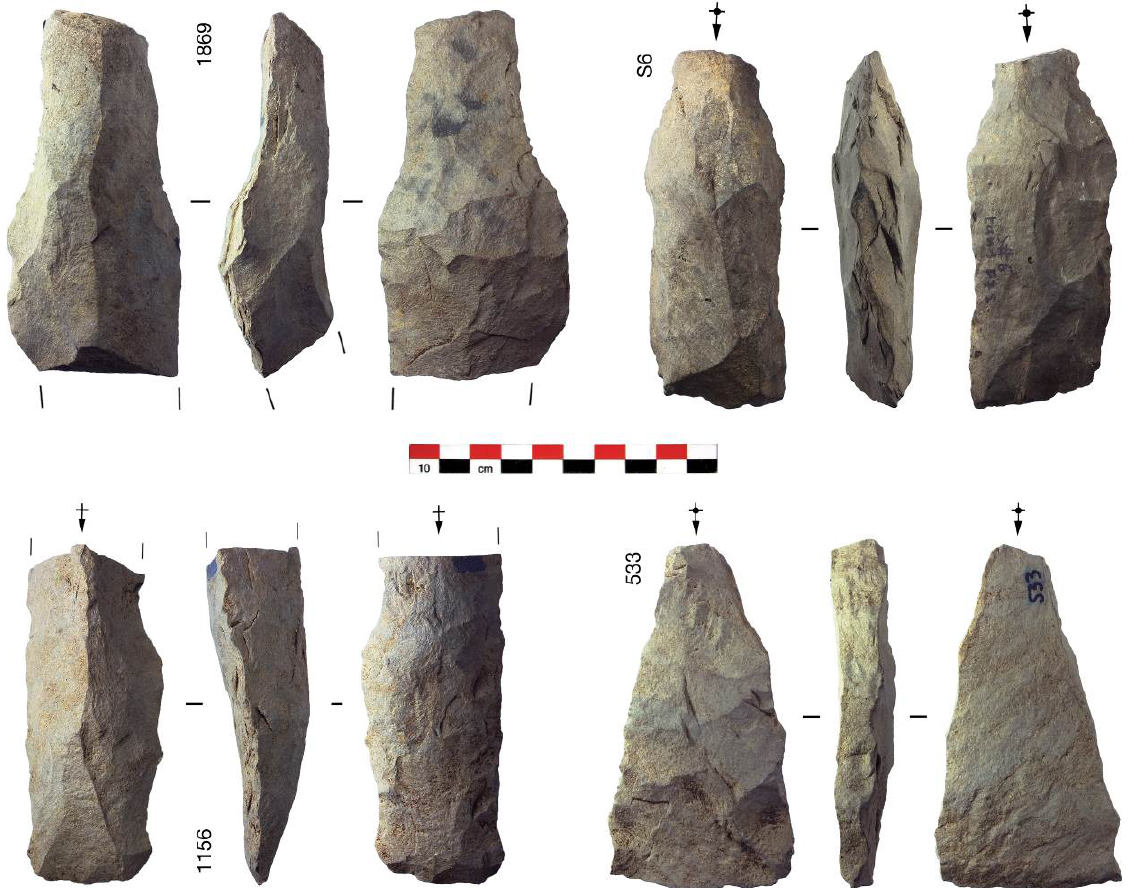
Figure 7. Préformes de Tanataetea: type 3A et 1B de Duff. Echelle de 10 cm (segments de 1cm) Figure 7. Tanataetea preforms: Duff type 3A and 1B. The scale bar in the image is 10 cm wide (separated into 1 cm